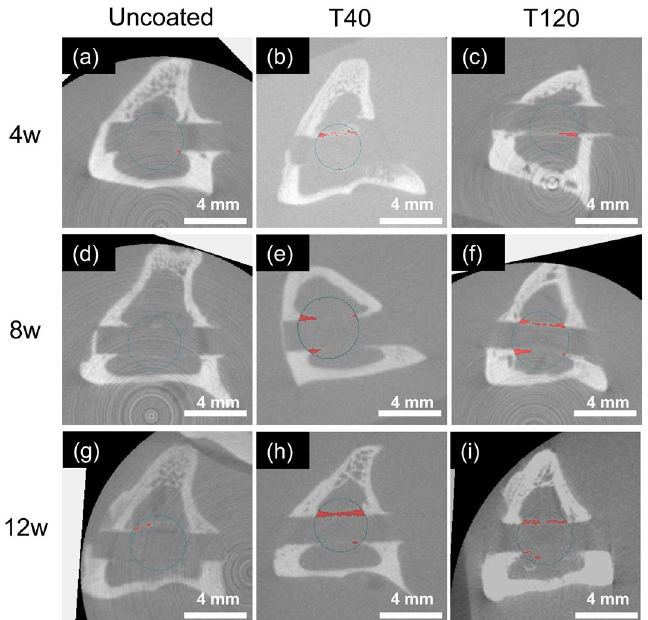
Figure 3. In vivo μCT images. The new bone volume surrounding the PEEK surfaces (red) inside the sphere (radius 2.5 mm) within the cancellous bone (green circle) was measured: ( a – c ) limited new bone formation was observed after 4 weeks; ( d – f ) T120 presented greater new bone formation compared to the uncoated implant after 8 weeks; ( g – i ) both T40 and T120 showed rich new bone formation, as opposed to the uncoated implant after 12